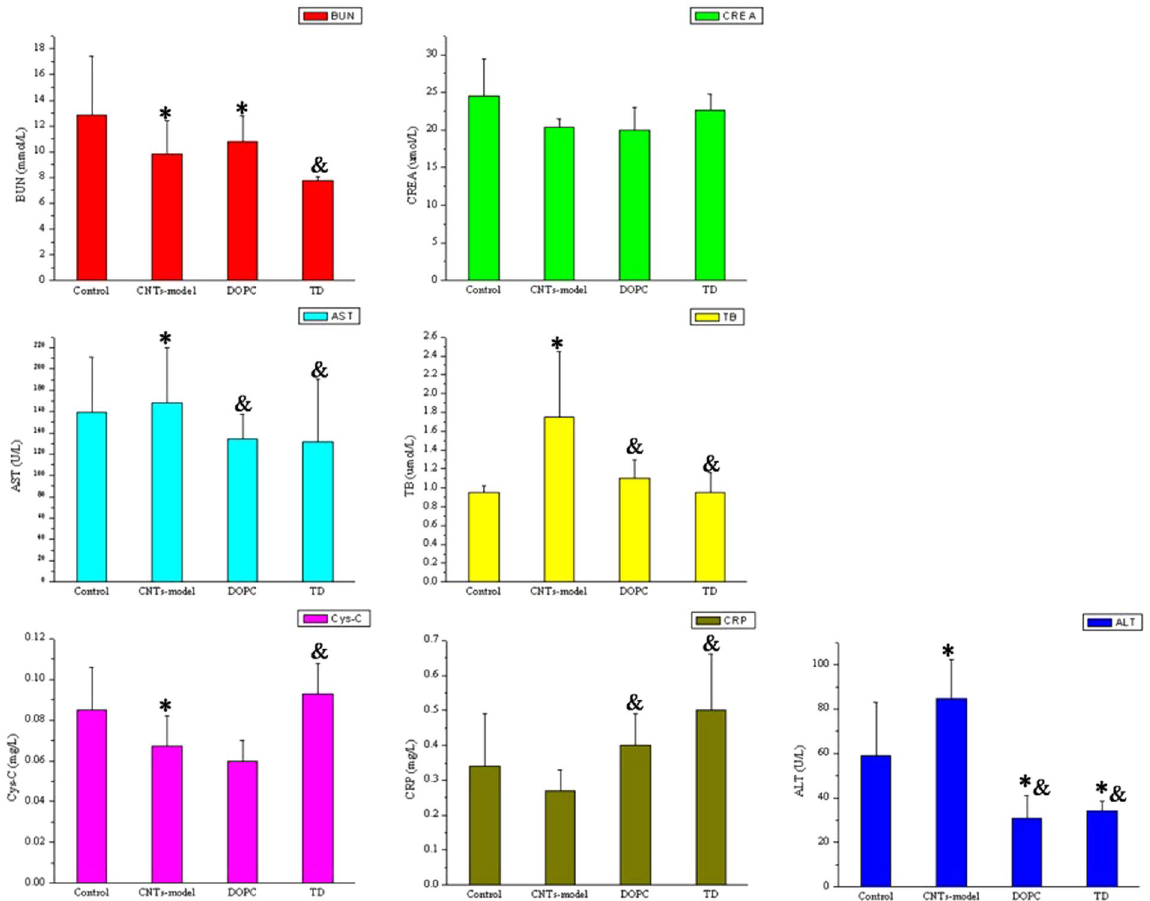
Figure 4. The biochemical indices level of BUN (blood urea nitrogen), CREA (creatinine), AST (aspartate aminotransferase), Cys-C (cystatin C), ALT (alanine aminotransferase), CRP (C-reaction protein) and TB (total bilirubin) change in plasma after exposure DOPC/or TD to oMWCNTs–model mice ( * p < 0.05 for groups vs . control group; & p < 0.05 for groups vs. oMWCNTs-model group; n = 5, +